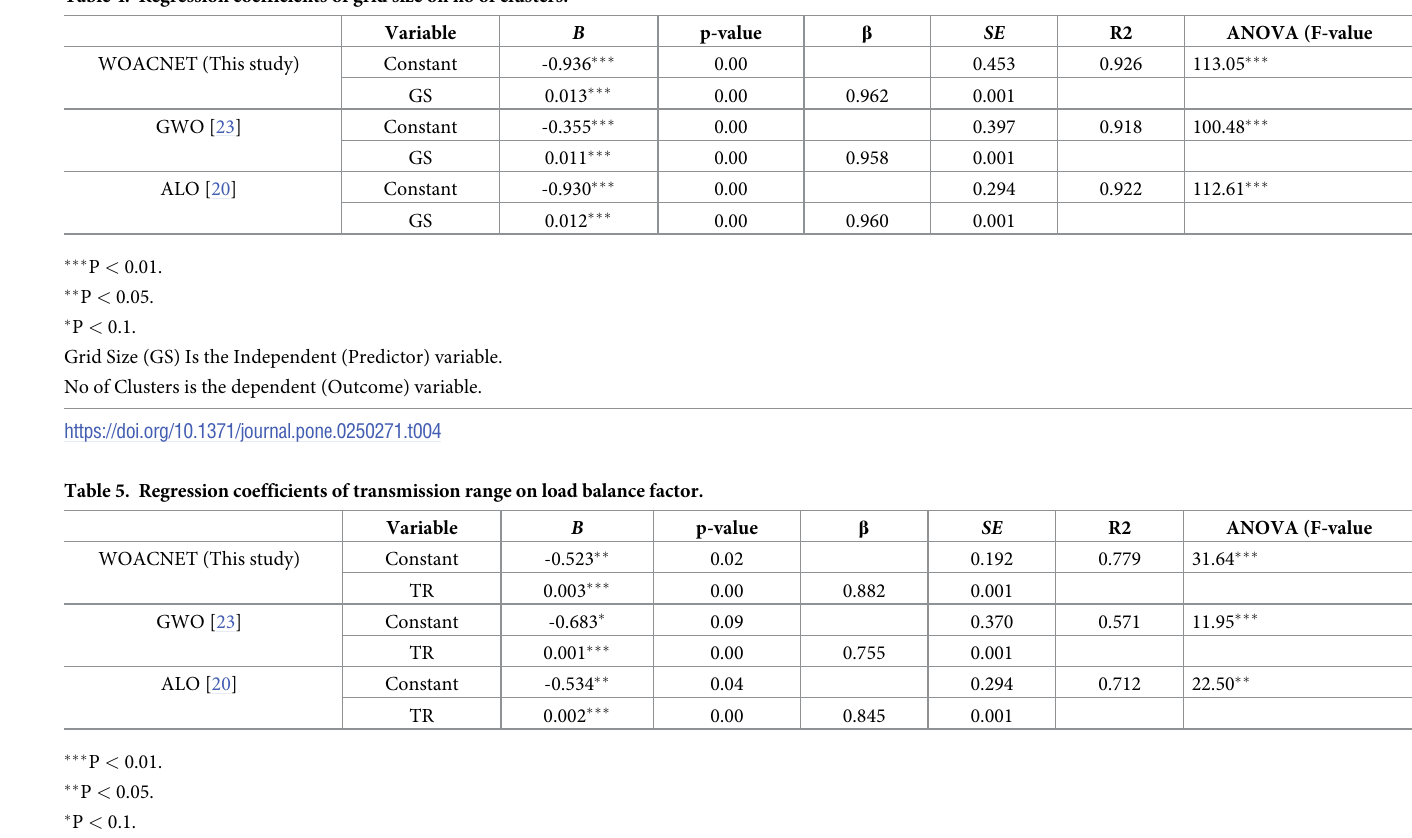
Table 4. Regression coefficients of grid size on no of clusters.